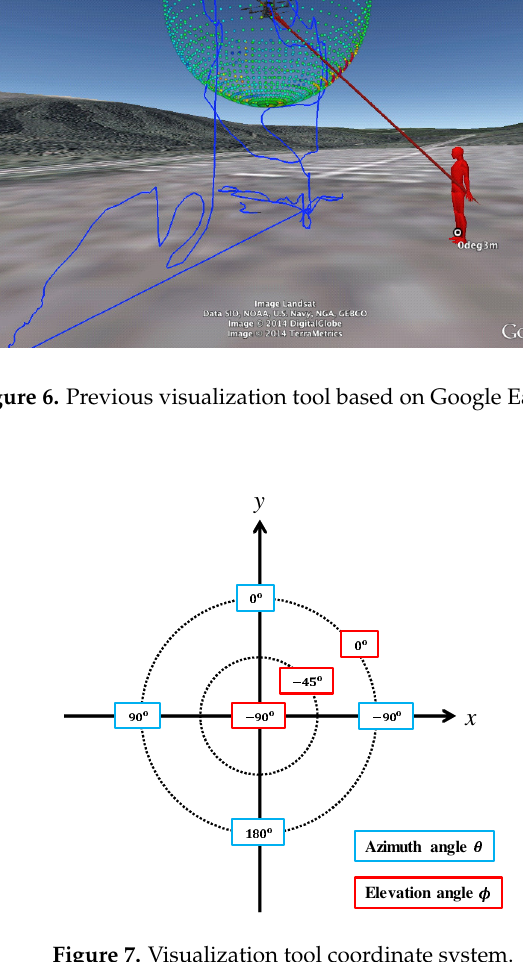
Figure 7. Visualization tool coordinate